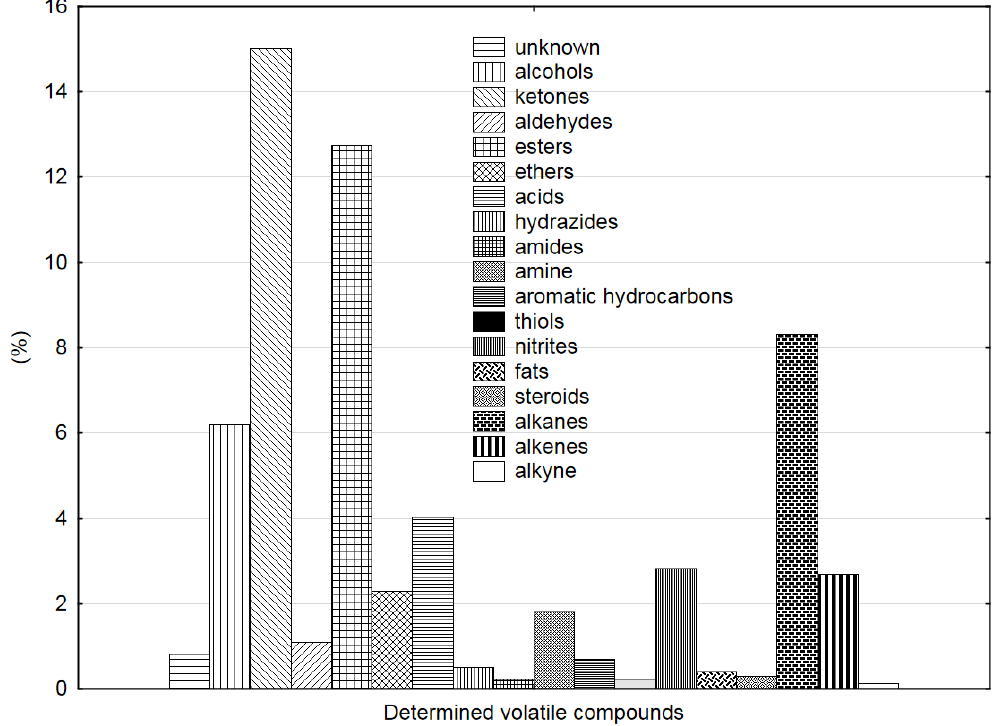
Figure 2. Percentage share of the main groups of volatile compounds in rapeseed during all days of storage.